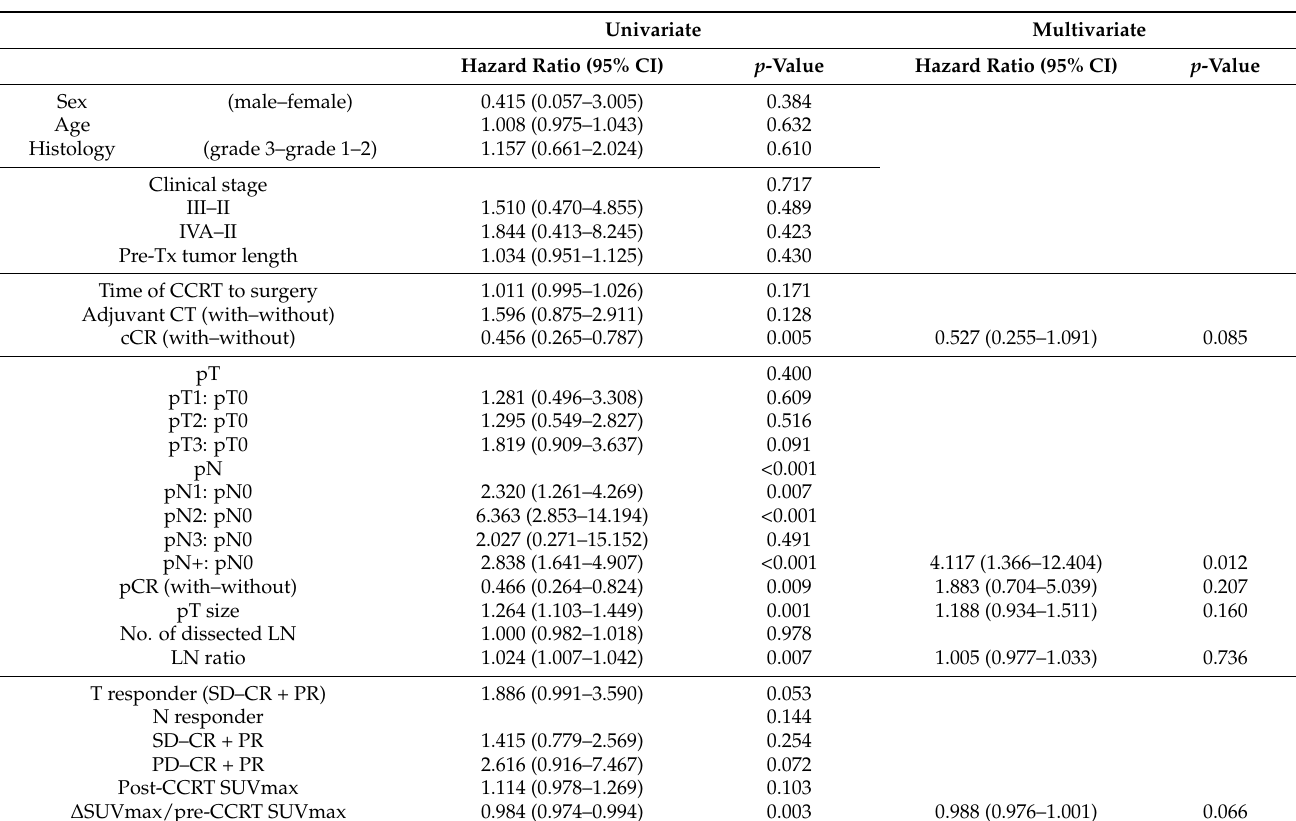
Table 3. Results of univariate and multivariate analyses with the Cox proportional hazards model on overall survivals.